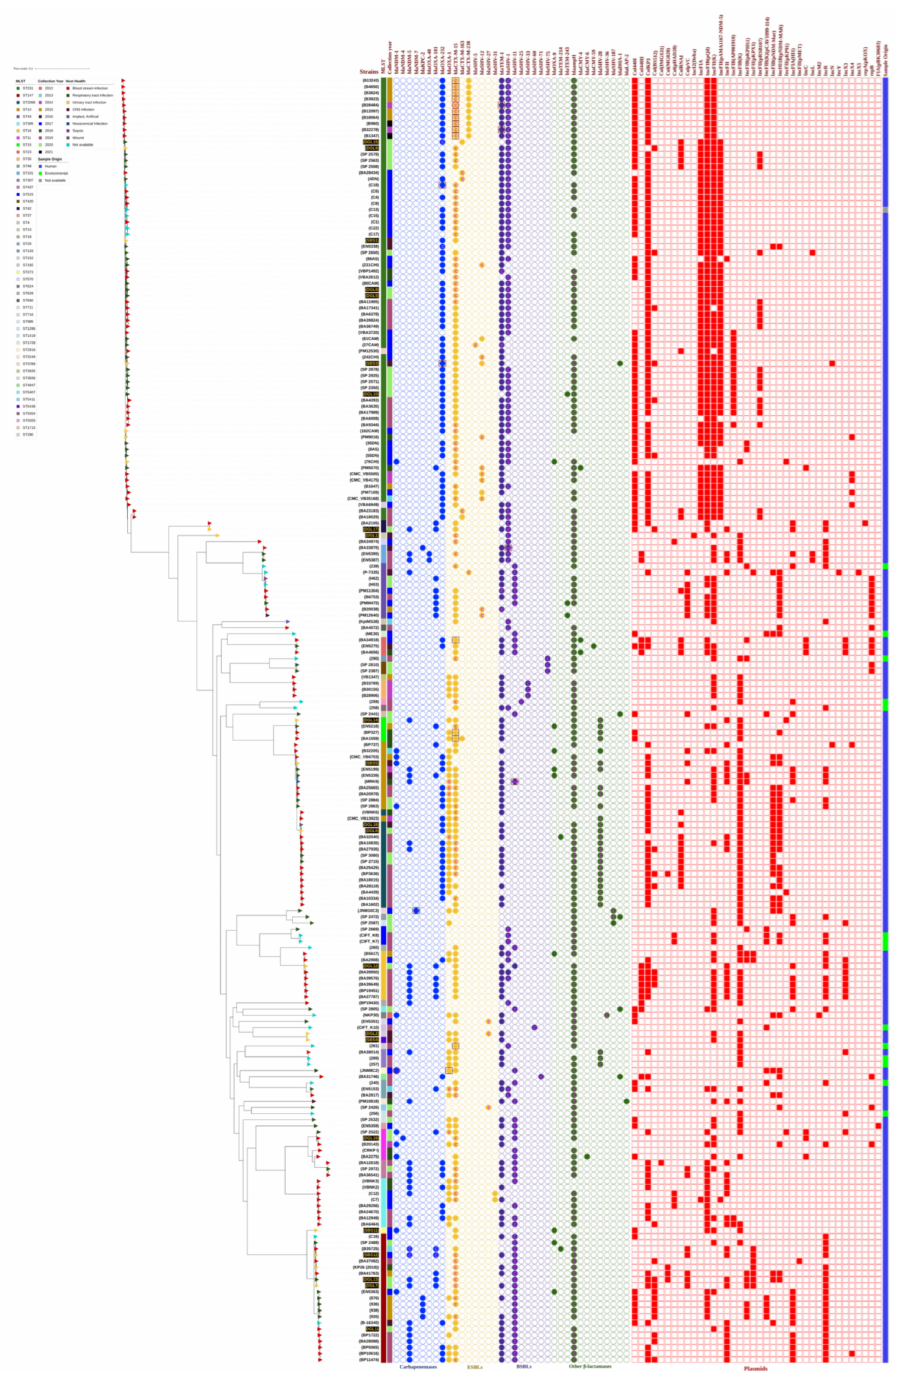
Figure 1. Genomic analysis of β -lactamase genes and plasmid replicons circulating in Kp genomes from India. Strains in yellow denote the lab isolates, black denotes retrieved genomes. Circles with filled color (blue—carbapenemase, yellow—ESBLs, purple—BSBLs, and green—other β -lactamases) for beta-lactamase genes denote the presence of genes, unfilled denotes the absence of genes. C inside a circle denotes the location of genes on the chromosome, without C denotes genes on plasmids. Red ring outside the circle denotes 3 copies of the gene, dark red square outside the circle denotes 2 copies of the gene. C and P denote that one is on chromosome and another is on the plasmid. For plasmids, red color-filled square denotes the presence of a plasmid, unfilled denotes the absence. iTOL was used to create this